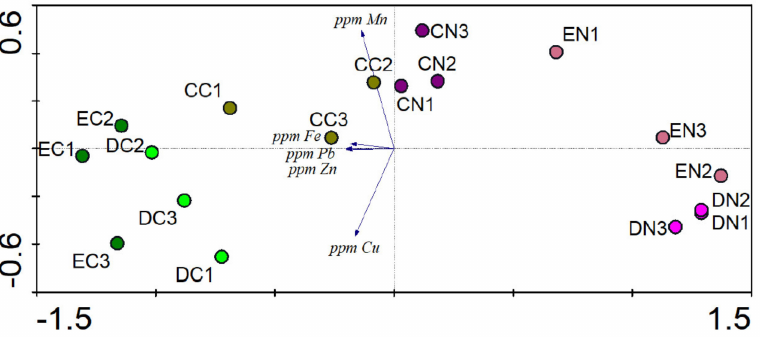
Figure 4. Principal Components Analysis (PCA) ordination diagram showing soil samples (points) spatially arranged according to the trace-element concentrations (arrows). CC= contaminated soil under C. salviifolius , CN= uncontaminated soil under C. salviifolius , DC= contaminated soil under D. viscosa , DN= uncontaminated soil under D. viscosa , EC= contaminated soil under E. pithyusa , EN= uncontaminated soil under E. pithyusa .